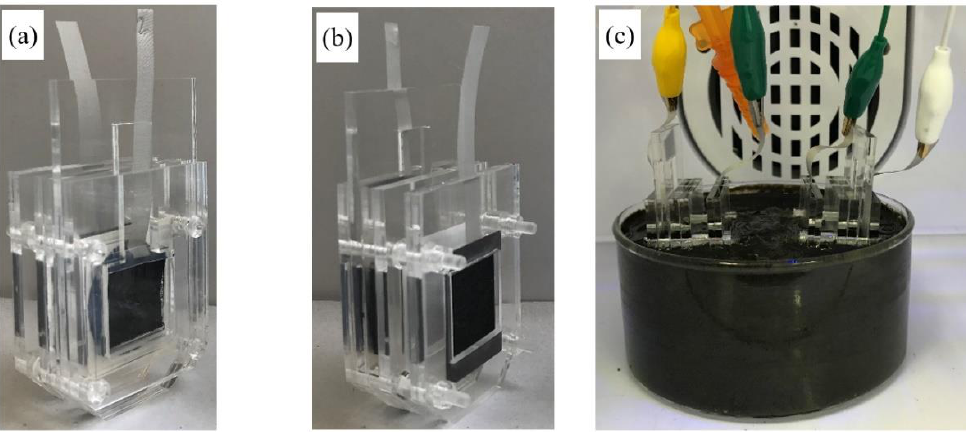
Figure 2. Photo images of the fabricated PSMFC: cathode side ( a ), anode side ( b ), and experimental setup with two PSMFCs ( c ).